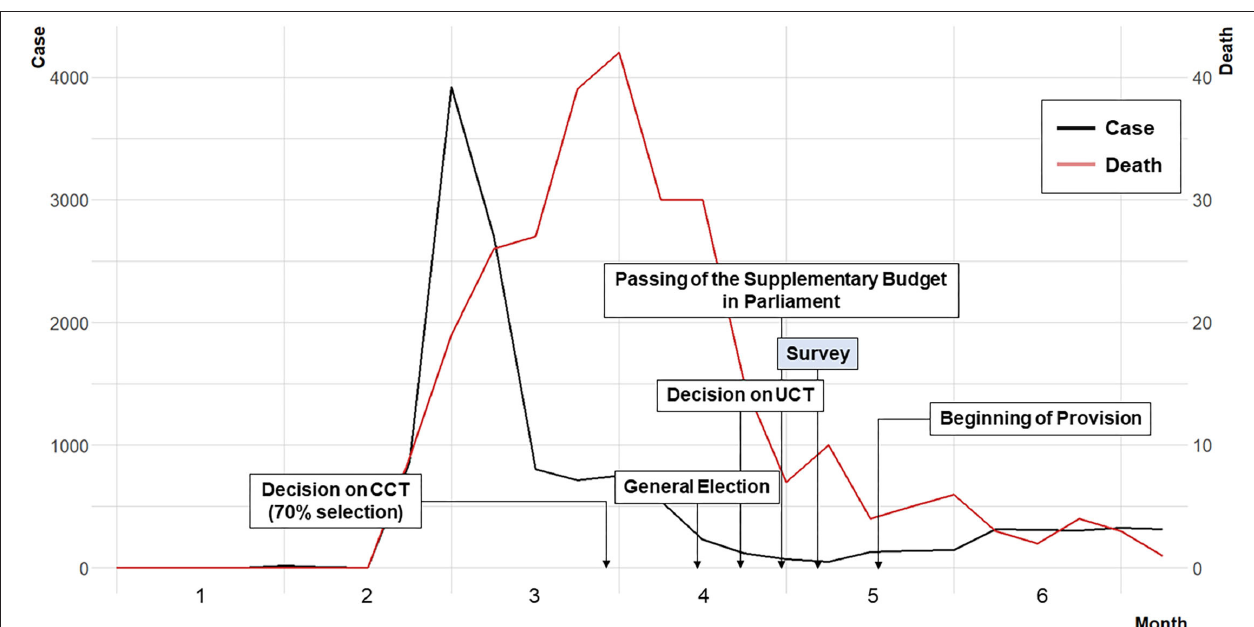
FIGURE 1 | Epidemic curve and the development of the cash transfer policy discourse in 2020. The cases and deaths were calculated as seven-day moving averages, and the main events were marked in boxes. CCT, conditional cash transfer; UCT, unconditional cash